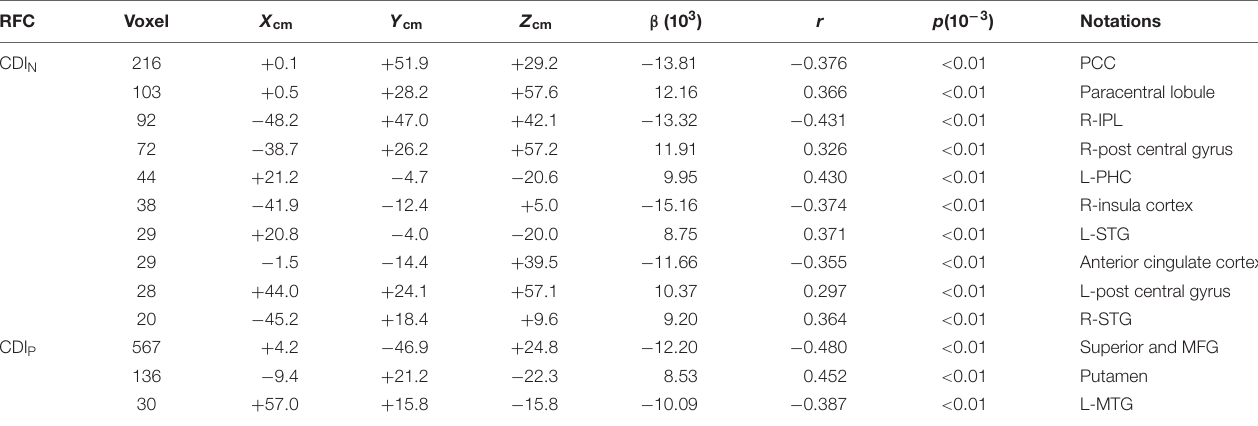
FIGURE 10 | The total volumes of the detected brain regions with significant correlation ( p < 0.05, corrected) between the connectivity density index (CDI P and CDI N ) and the subject’s age as a function of the kernels (A) . The average regression parameter β for the detected brain regions as a function of the kernels (B) . The negative and positive correlations were assessed separately. TABLE 3 | The joint overlapping brain regions where the connectivity density metrics of different kernels are all significantly ( p < 0.05) correlated with the subjects’